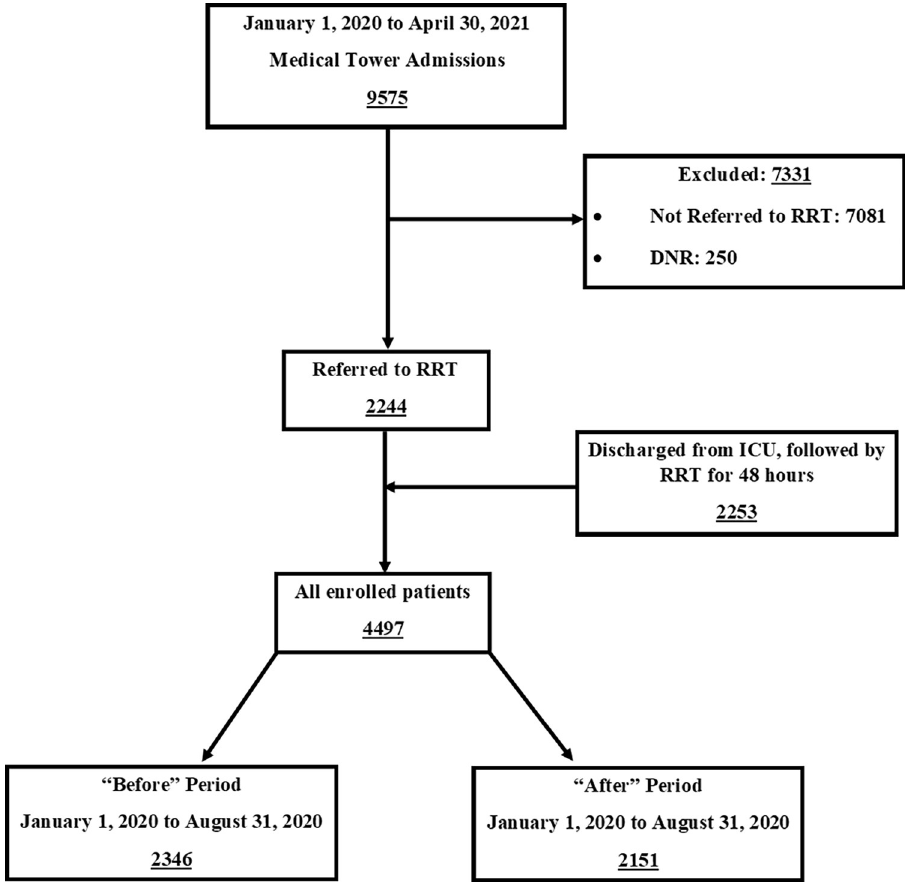
Fig 1. Patients’ enrollment flow